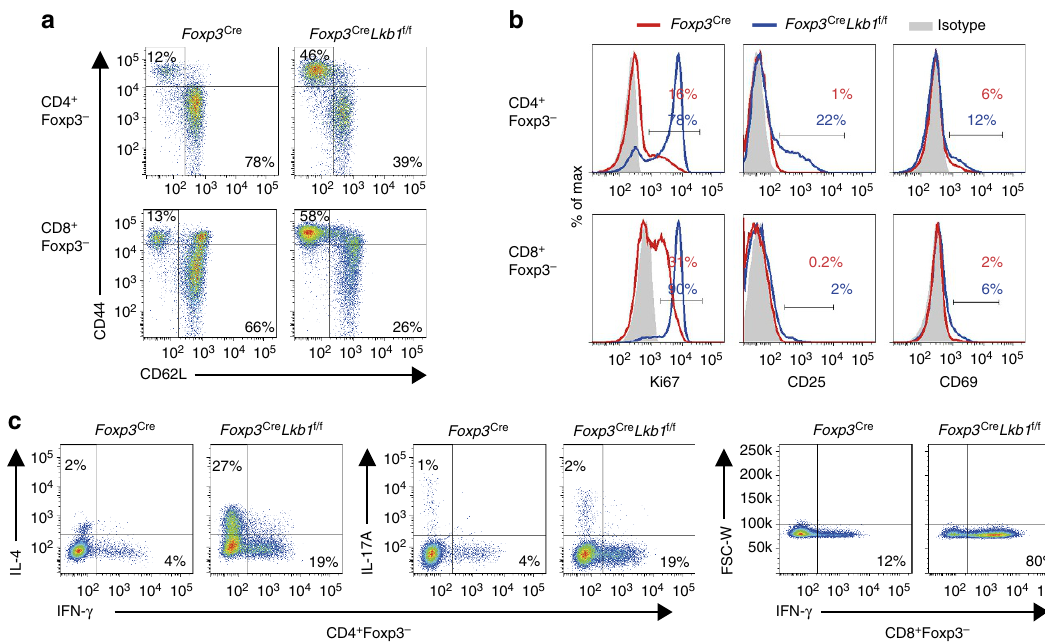
Figure 2 | Spontaneous activation of conventional T cells in Foxp3 Cre Lkb1 f/f mice. ( a ) Expression of CD44 and CD62L on splenic CD4 þ Foxp3 (cid:2) and CD8 þ Foxp3 (cid:2) Tcells from Foxp3 Cre and Foxp3 Cre Lkb1 f/f mice. ( b ) Expression of Ki67, CD25 and CD69 in splenic CD4 þ Foxp3 (cid:2) and CD8 þ Foxp3 (cid:2) Tcells from Foxp3 Cre and Foxp3 Cre Lkb1 f/f mice. ( c ) Intracellular staining of cytokines in splenic CD4 þ Foxp3 (cid:2) and CD8 þ Foxp3 (cid:2) T cells from Foxp3 Cre and Foxp3 Cre Lkb1 f/f mice stimulated with phorbol myristate acetate (PMA) and ionomycin for 4h. All mice analysed were 28–30 days old. All data are representative of at least three independent